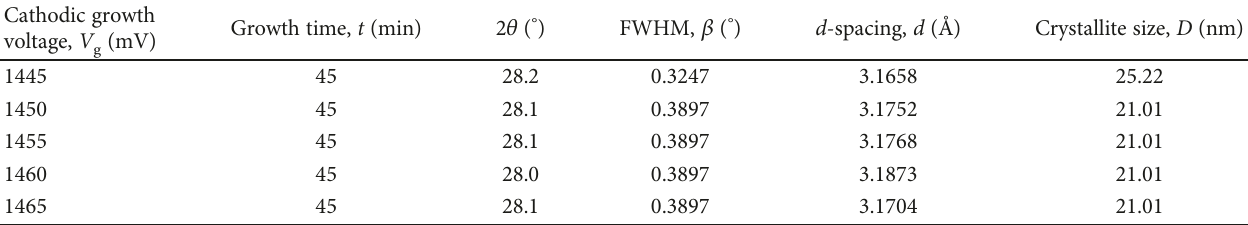
Table 1: XRD analysis of the (101) hexagonal peak for as-deposited CdS thin fi lms grown at di ff erent cathodic voltages. Cathodic growth Growth time, t (min) voltage, V (mV) g